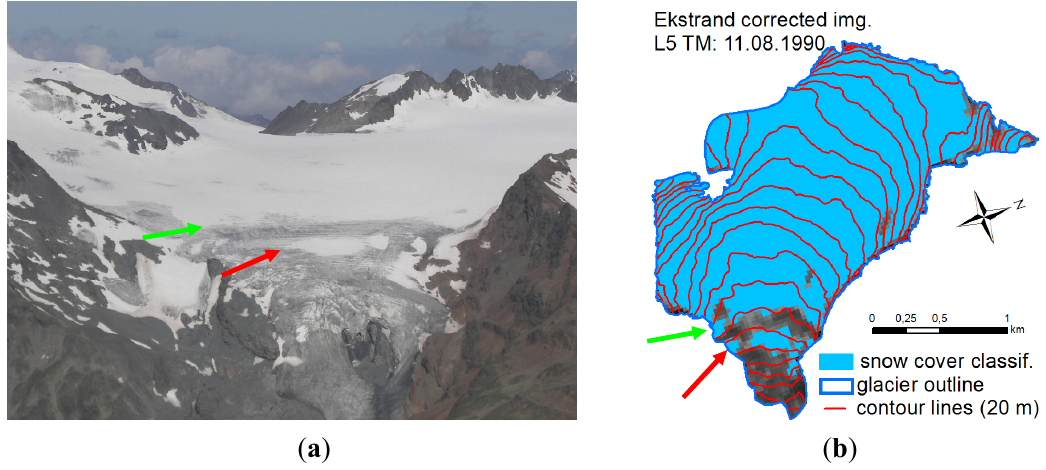
Figure 4. ( a ) Patchy distribution of SC on Kesselwandferner (photo by Christian Engl, 1 July 2007). ( b ) Classified SC distribution for similar snow conditions (11 August 1990). The usage of only one elevation bin (red arrow) for snow line altitude (SLA) determination could be erroneous, as the SC in one elevation bin is greater than 50%. The green arrow indicates the correct bin to derive the SLA.